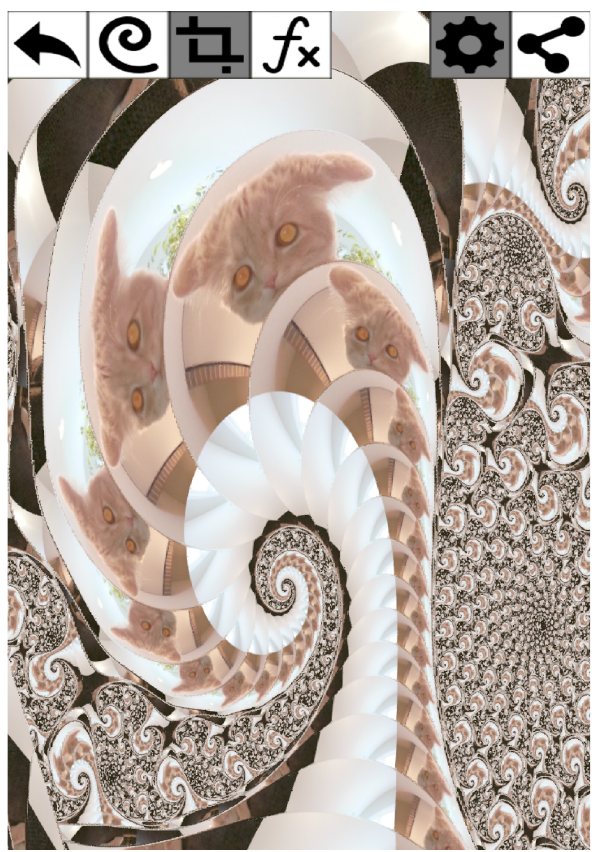
Figure 2 | Screenshot of PhotoFrac for